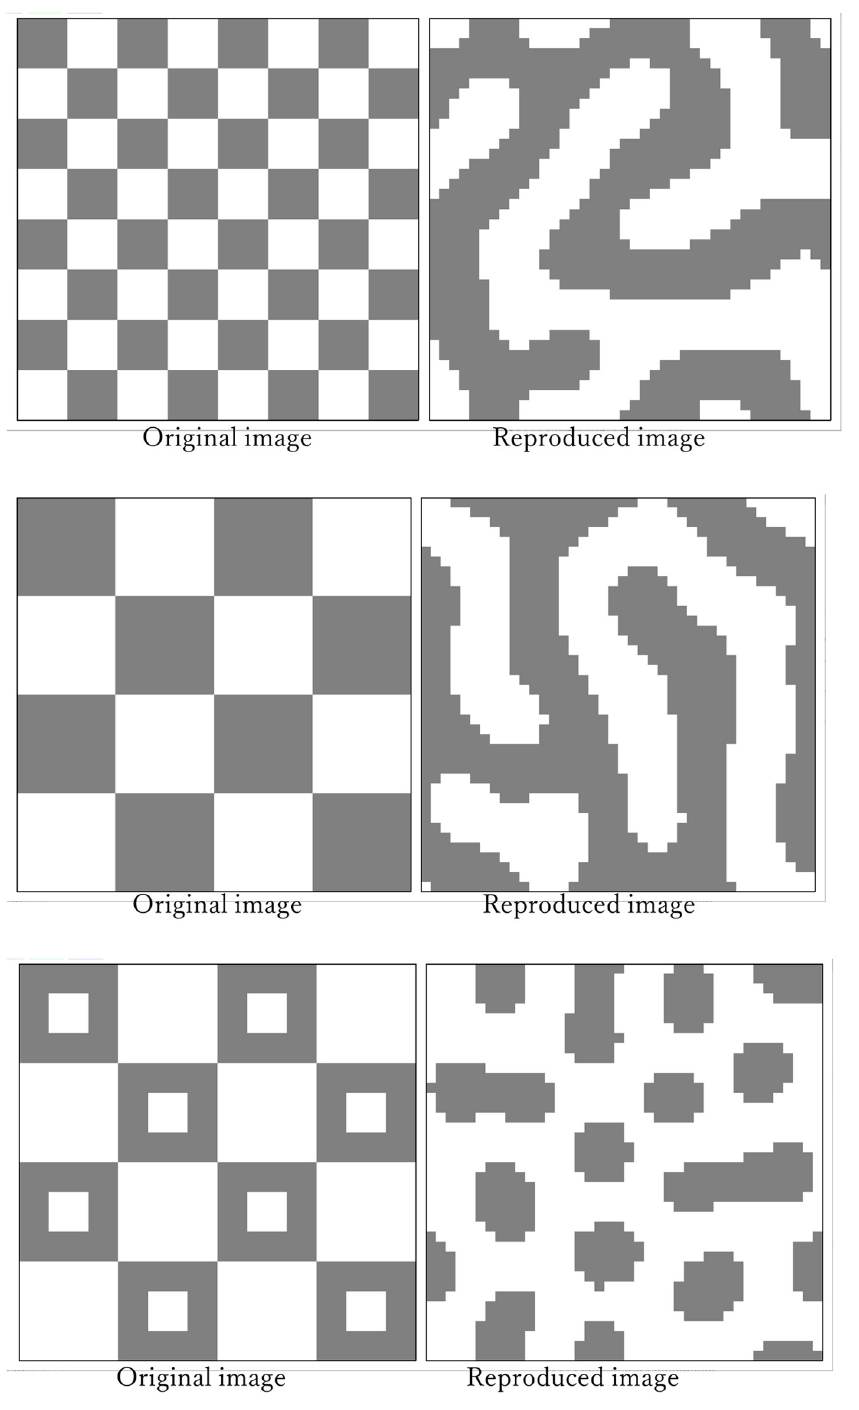
Fig 15. Reproduced results of the checkerboard